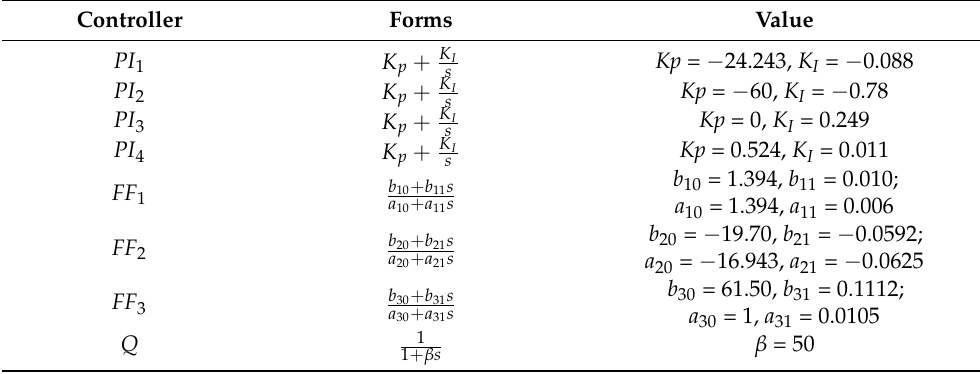
Table 2. Parameters of the designed